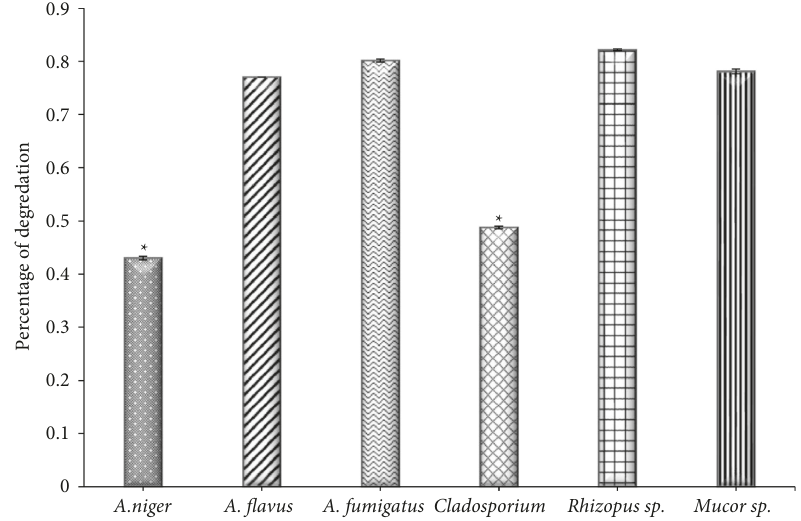
Figure 2: The activity of lipase of endophytic fungi isolated from Ziziphus spina leaves on solid medium. ∗ Significant difference with ( A. flavus, (A) fumigatus, Rhizopus sp., and Mucor sp. ), at P < 0 . 001.